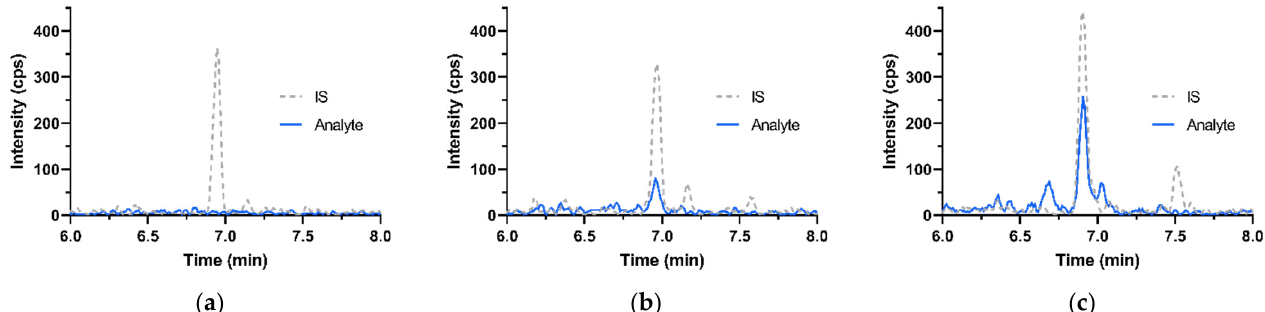
Figure 3. MRM chromatograms of the analyte 3-OH-BaP ( m / z 360 → 251) and the internal standard 13 C 6 -3-OH-BaP ( m / z 366 → 257). ( a ): Non-smoker urine sample (<LOD); ( b ): quality control sample with low concentration (c = 162 pg/L); ( c ): smoker urine sample (c = 470 pg/L).